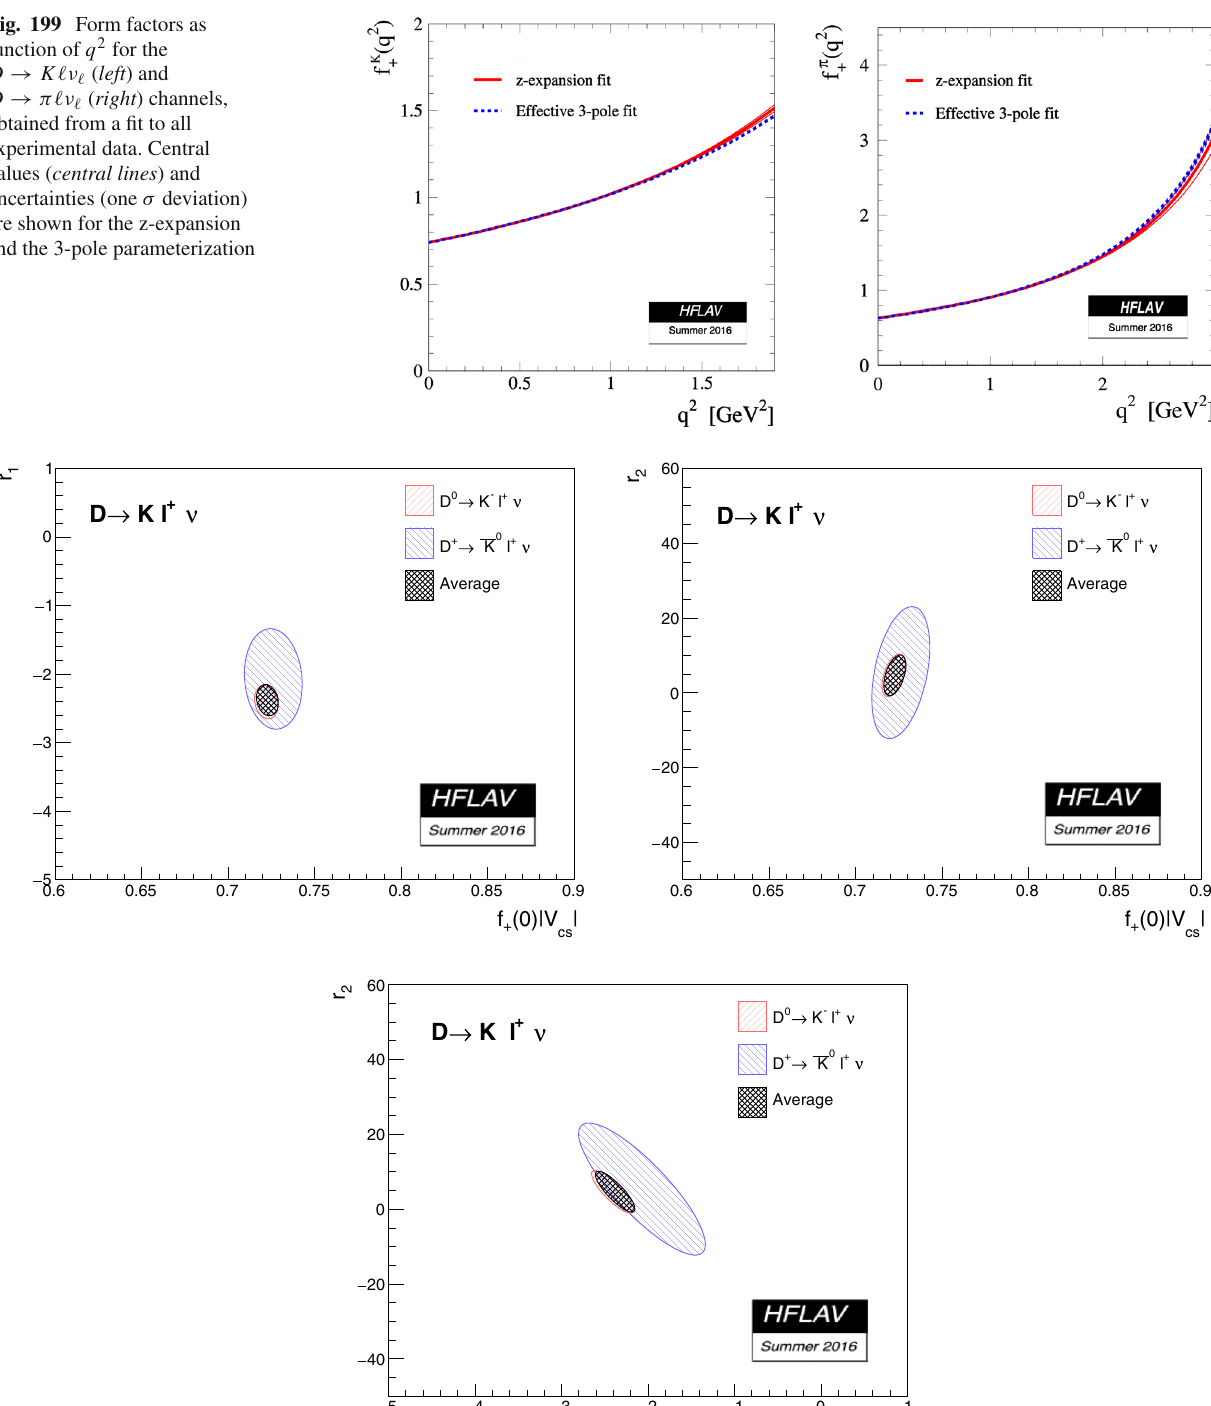
Fig. 200 Results of the combined fit shown separately for the D 0 → K − (cid:12) + ν and D + → ¯ K 0 (cid:12) + ν decay channels. Ellipses are shown for 68% C.L 8.5.9 Combined results for the D → π(cid:12)ν (cid:12) channel data, with updated input values from [327]. The available measurements are fitted in bins of q 2 to the z -expansion The combined result for the D → π(cid:12)ν (cid:12) decay channel is model at second order. Results of the individual fits for obtained from a fit to BaBar , Belle, BES III, and CLEO-c each experiment and the combined result are shown